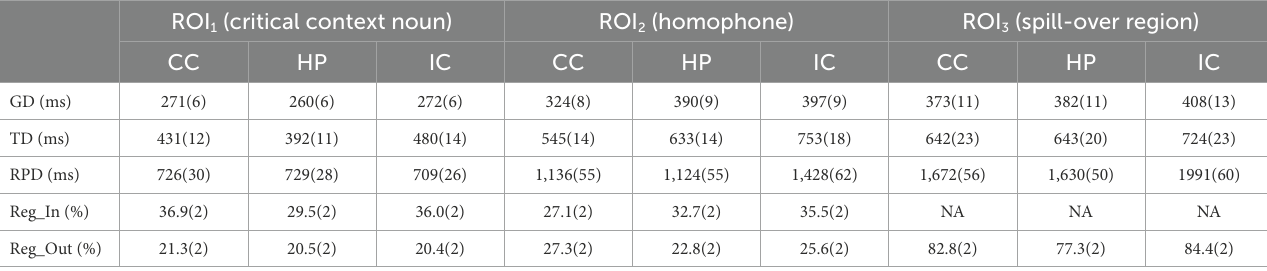
TABLE 3 Fixation data of different regions of interest (ROIs) in the three experimental conditions. ROI (critical context 1